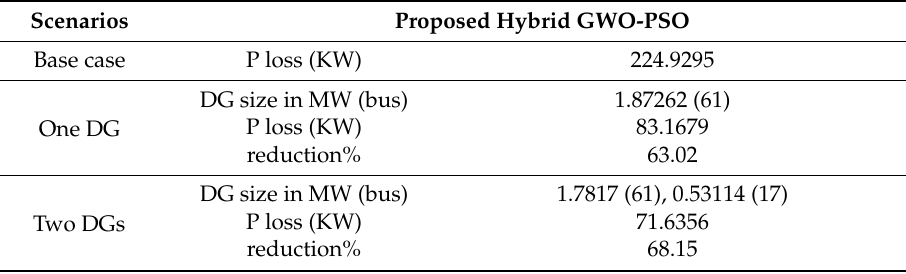
Table 1. Different penetrations of DG units for a 69-bus